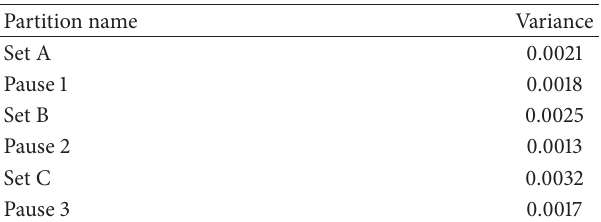
Figure 3: Division of moving and stationary partitions each at 7 and 2 minutes, respectively. Table 4: Sample result of calculated variance between partitions of moving and stationary